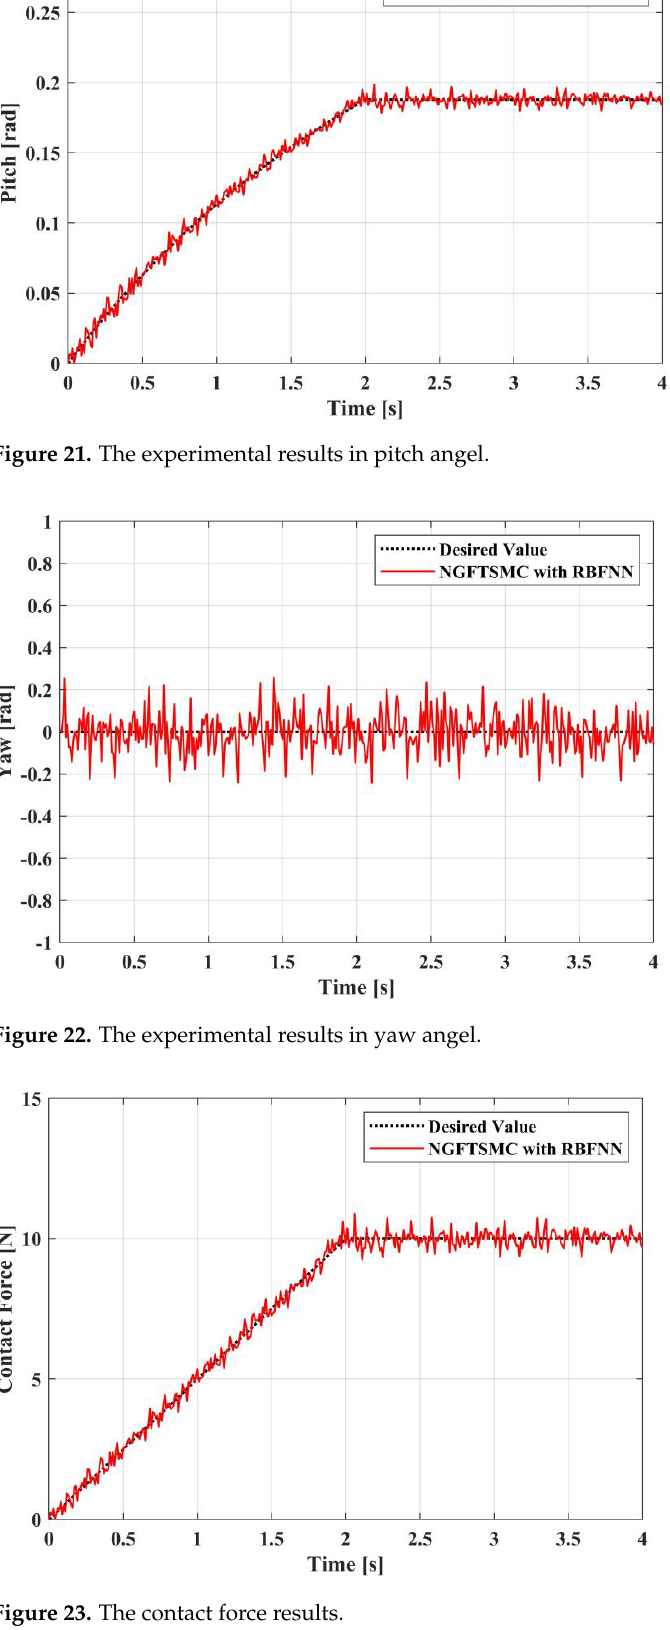
Figure 23. The contact force results.